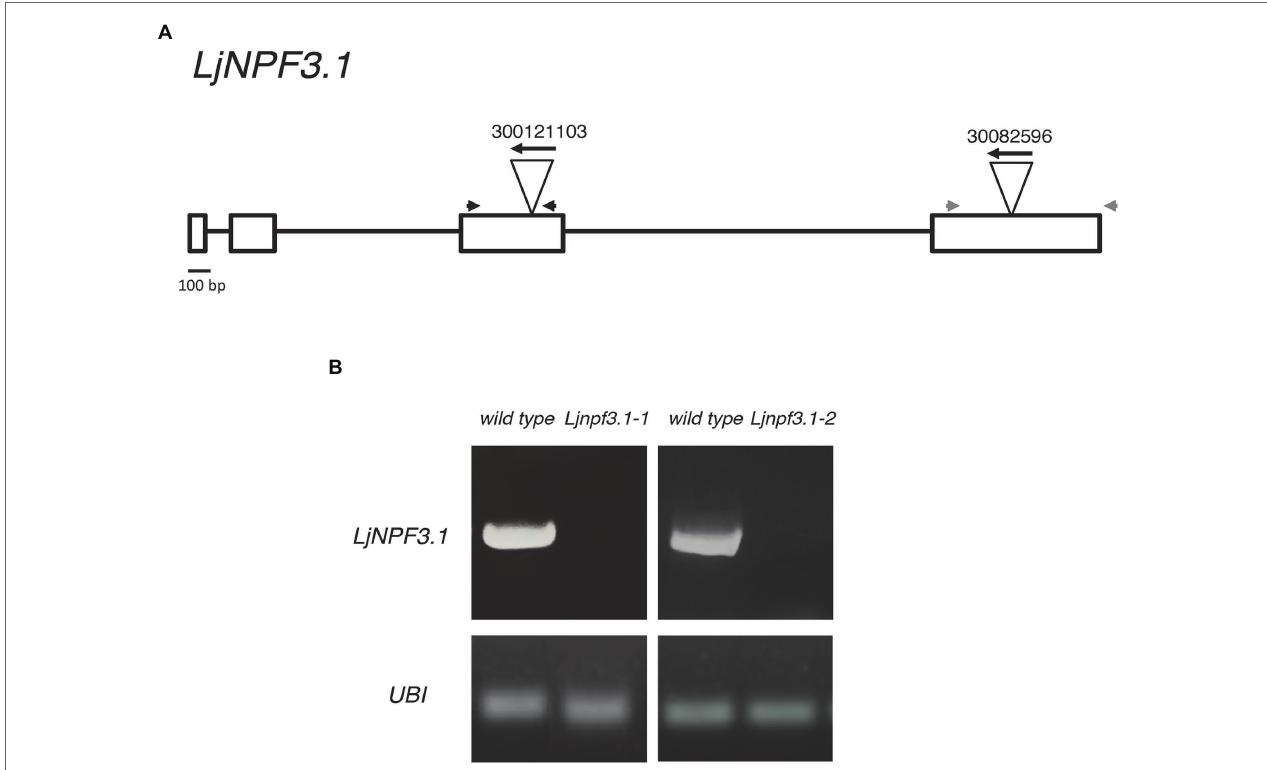
FIGURE 4 | (A) Exon/intron organization of the LjNPF3.1 gene. Insertion sites, relative orientations of the LORE1 retrotransposon element in the 300121103 and 30082596 lines, and positions of a couple of primers (gray and black arrowheads) used for genotyping are indicated. (B) LjNPF3.1 is not expressed in LORE1 homozygous mutant